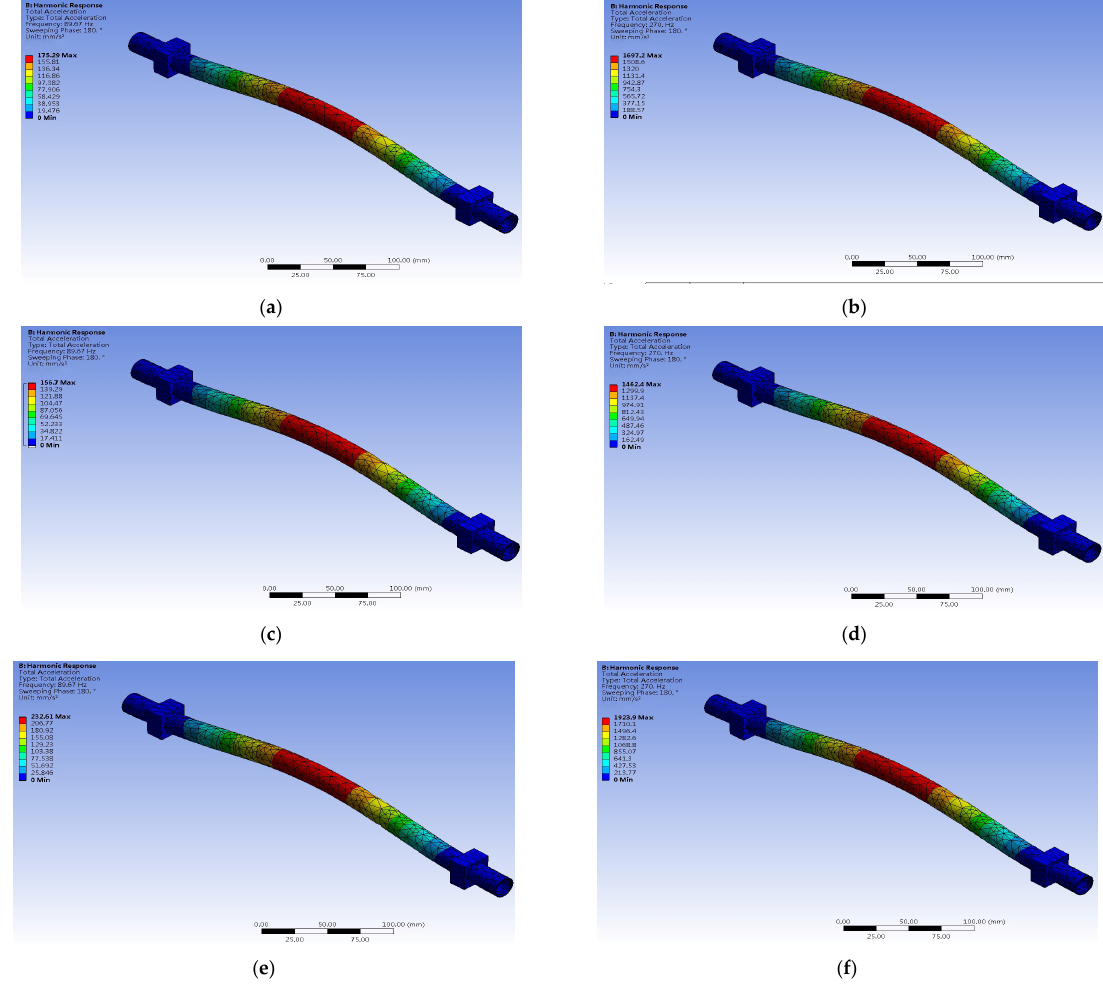
Figure 7. Aviation hydraulic pipeline acceleration response nephogram.